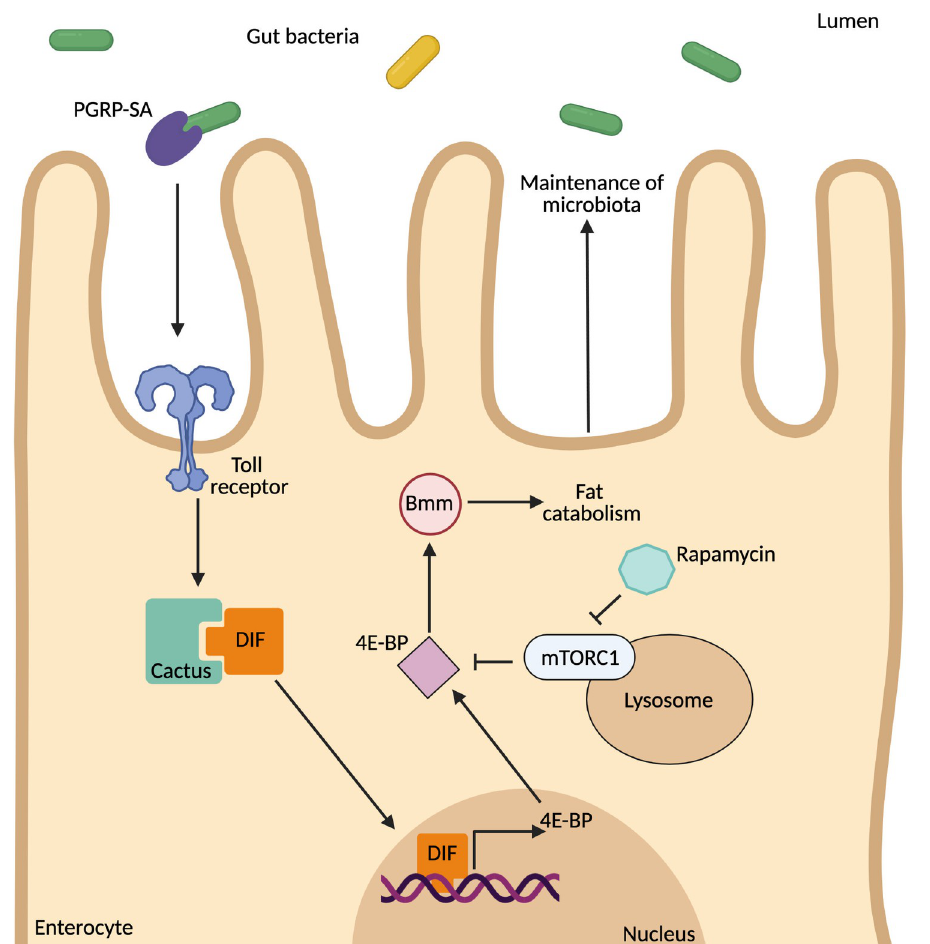
Fig 11. A schematic model outlining the role of PGRP-SA/Toll/Dif in the retention of the gut bacteriome. PGRP-SA recognises components of the intestinal bacteriome and activates the Toll pathway in enterocytes. This increases 4E-BP transcription/4E-BP protein phosphorylation in enterocytes. 4EBP is important for maintaining normal density of commensal bacteria. We hypothesise that Bmm-mediated lipid catabolism is regulated by 4E-BP and released triglycerides act as fuel for the maintenance of commensal